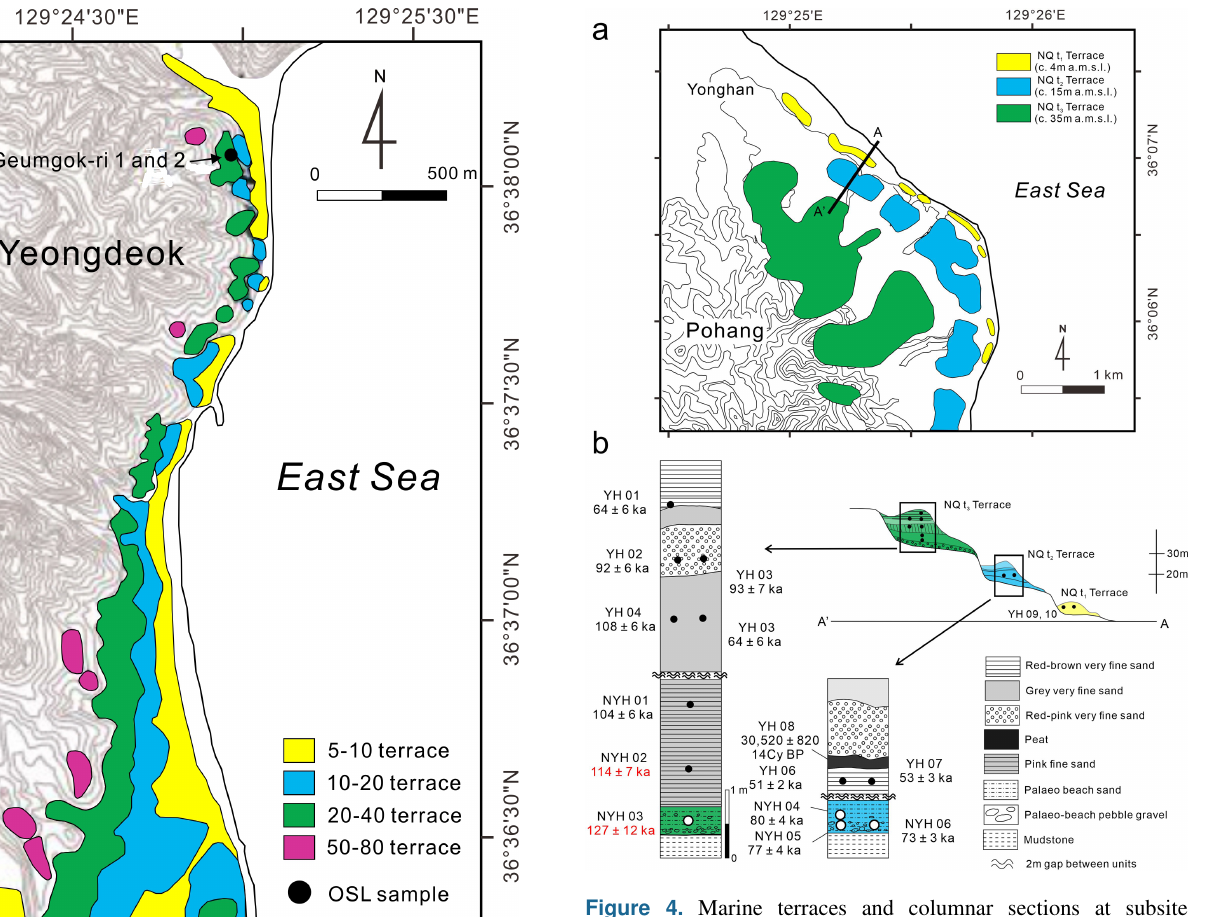
Figure 4. Marine terraces and columnar sections at subsite Yonghan-2 of the Pohang area in the eastern Korean Peninsula (modified after Choi et al., 2009). (a) Plan view on the shoreline showing three ages of terraces. (b) Schematic cross section and columnar sections of paleo-beach sediments overlain by aeolian sand on terraces. Open and closed circles indicate the location of OSL ages from paleo-beach and aeolian sand sediments, respec- tively. Two ages in red indicate LIG ages (WALIS LUM ID no. 449 and no. 450 in Table 3). Sites YH09 and YH10 in the NQt 1 terrace (yellow) were dated to 0.09 ± 0.01 and 0.11 ± 0.01ka by OSL, re- spectively (Choi et al., 2009). The topographic contour interval is 10m. For location, see Fig. 2. a.m.s.l.: above mean sea